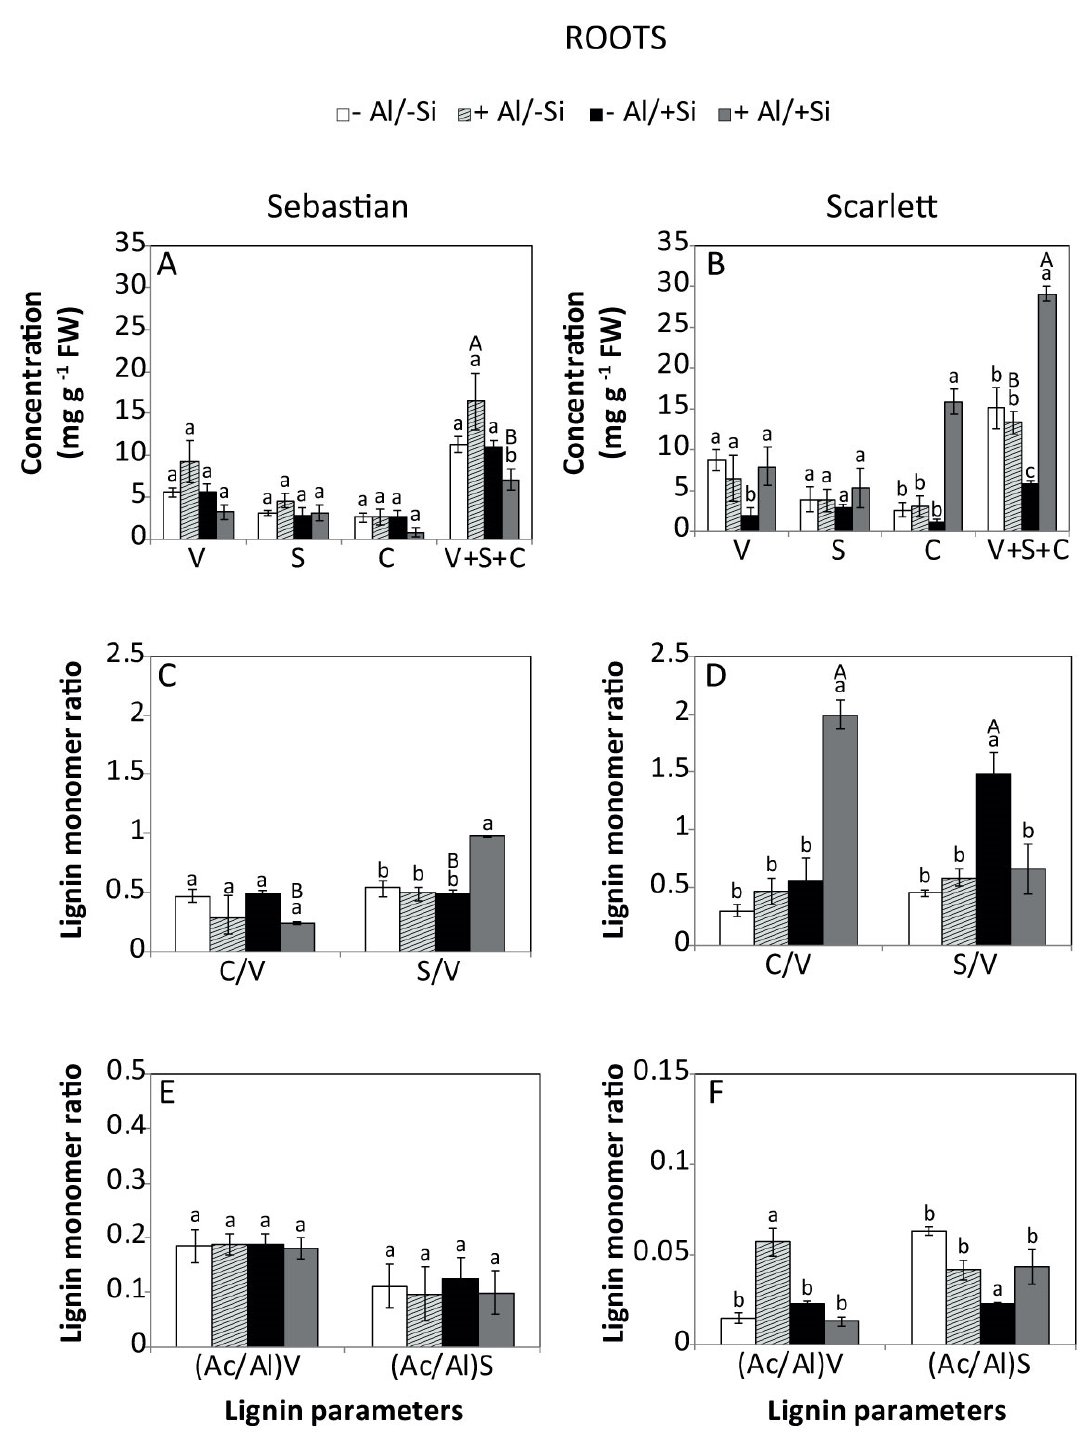
Figure 6. Lignin parameters of the roots of Sebastian and Scarlett barley cultivars. The main lignin groups ( A / B ), comprising vanillyl [V], syringyl [S] and cinnamyl [C] phenols, and total lignin concentration [S + V + C]; their ratios ( C / D ); and acid to aldehyde ratios ( E / F ) of vanillyl [(Ac/Al)v], and syringyl [(Ac/Al)s]. Treatments were 0 or 0.2 mM Al, combined with Si (0 or 2 mM). Values represent the mean of three replicates per treatment ± SD. Different letters indicate statistically significant differences ( p ≤ 0.05) among treatments. The lower case letters represent significant differences between treatments for the same barley cultivar. The upper case letters indicate significant differences between barley cultivars for the same treatment. When uppercase letters do not appear, no significant differences between the same treatment in different cultivars were found.